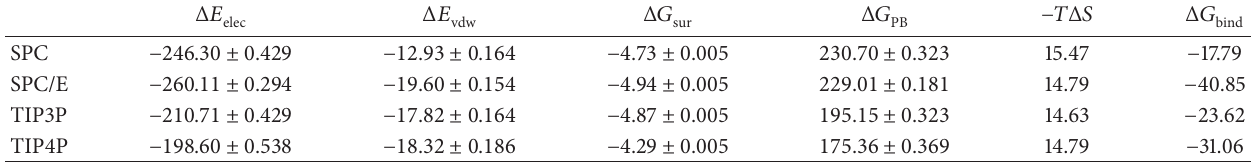
Table 5: The same as in Table 3 but for CHARMM27 force